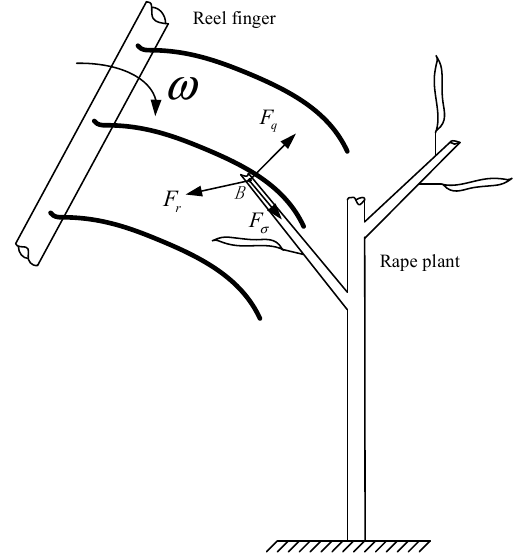
Figure 1. Analysis of shifting force on rape plant by reel finger.